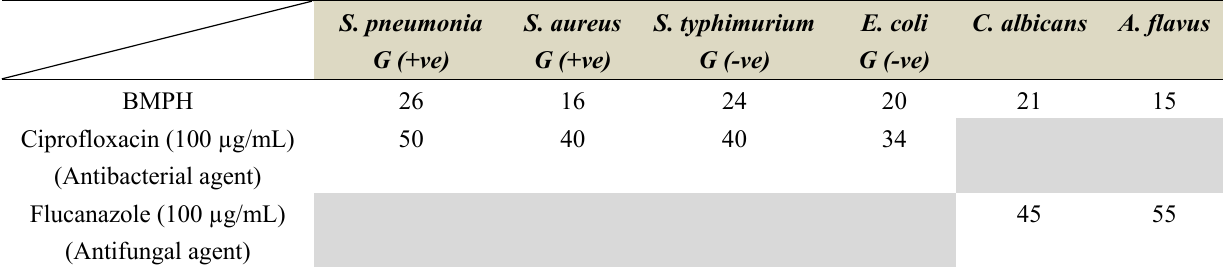
Table 6. Antimicrobial activity of BMPH against some bacteria and